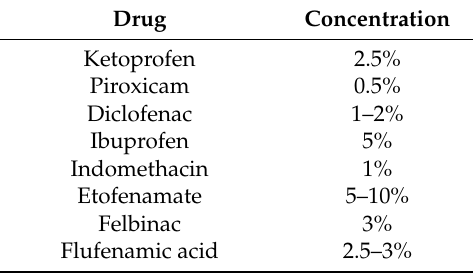
Table 4. Non–steroidal anti-inflammatory drugs used for topical application and their usual